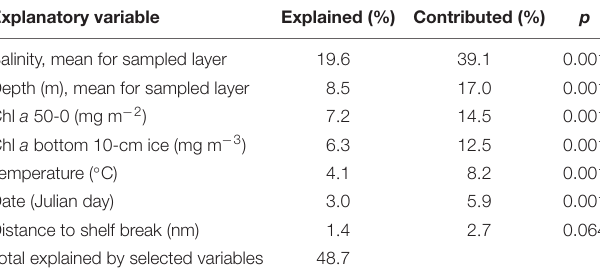
TABLE 4 | Results of forward selection of environmental variables in CCA